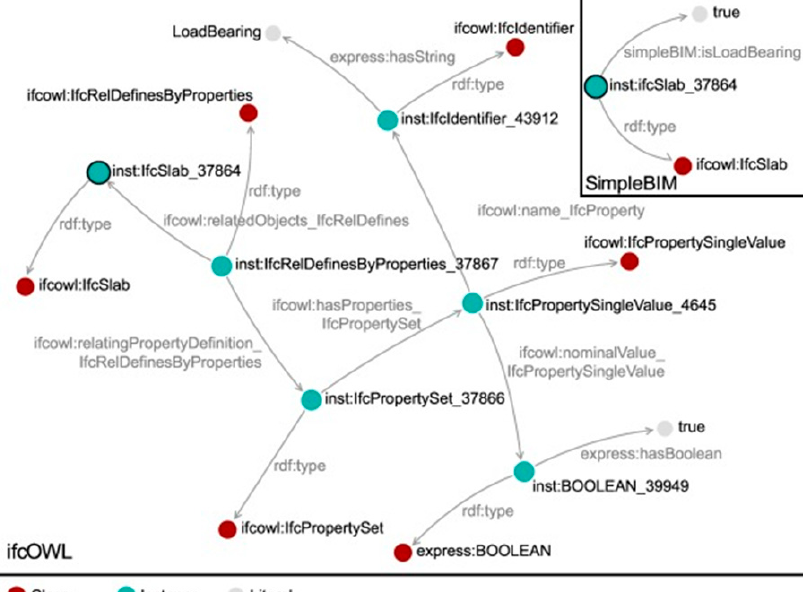
Figure 5. Visual complexity comparison of representing property assignment using ifcOWL and simpleBIM [74] (Reprinted from Elsevier Automation in Construction, Volume 108/December